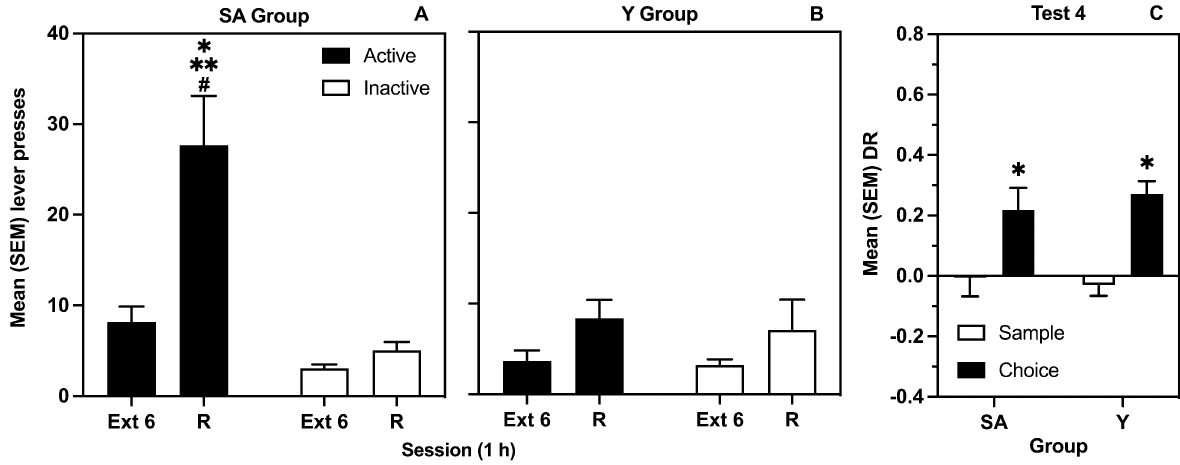
Figure 5. Effects of the discrete heroin CS on reinstatement of lever responses and object location memory. Mean (SEM) active and inactive lever presses during the last extinction (Ext 6) and the cue-induced reinstatement (R) sessions for rats in the SA ( A ) and Y ( B ) groups. The * indicates a significant difference between levers. The ** indicates a significant difference in active lever responding from Ext 6 to R. The # indicates a significant difference in active lever responding between SA and Y groups. ( C ) mean (SEM) DRs from sample and choice phases of SA and Y groups on the test of memory modulation by the reinstatement session. The * indicates a significant difference between